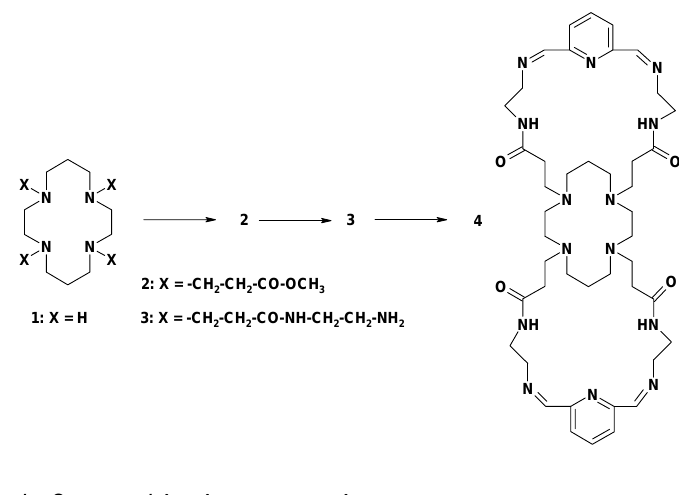
Figure 10. The synthetic route to compound 4 .